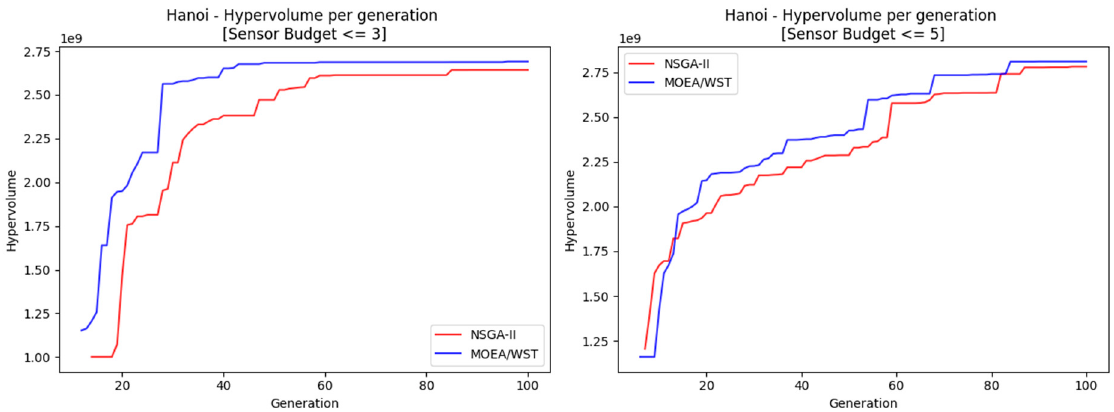
Figure 14. Hypervolume per generation.